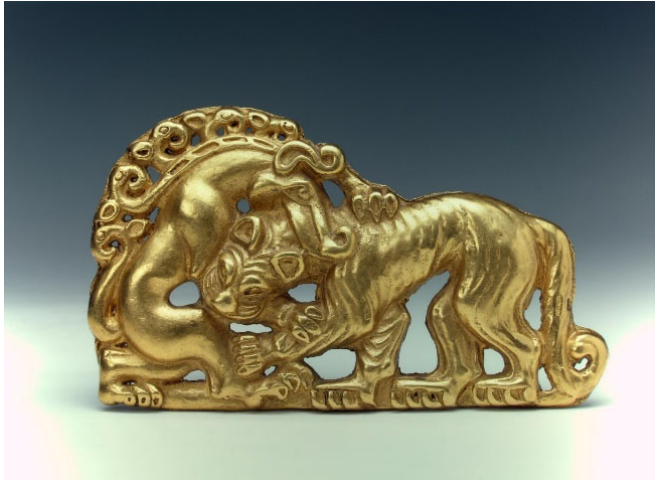
Figure 20. Belt buckle with a contest scene between a tiger and an underworld monster (SHM inv. no. C и .1727 ‐ 1/11); cast gold; Siberian Collection of Peter I; c. 4th to 3rd century BC. [Image is used from